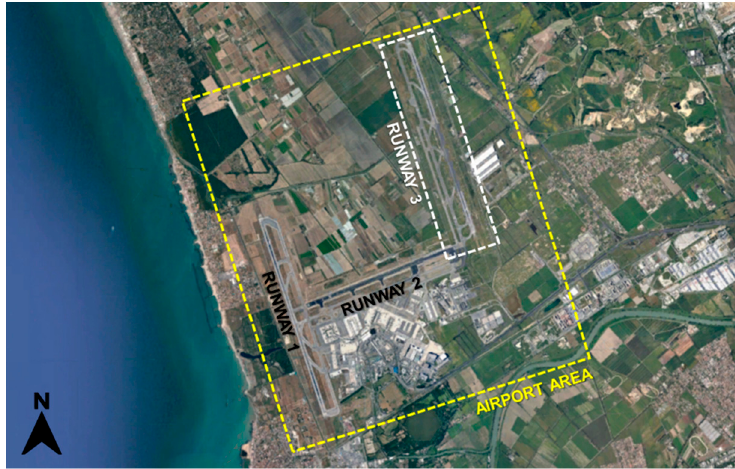
Figure 1. Satellite view of “Leonardo Da Vinci” International Airport and location area of Runway 3 (Google Earth Image, 2015) .